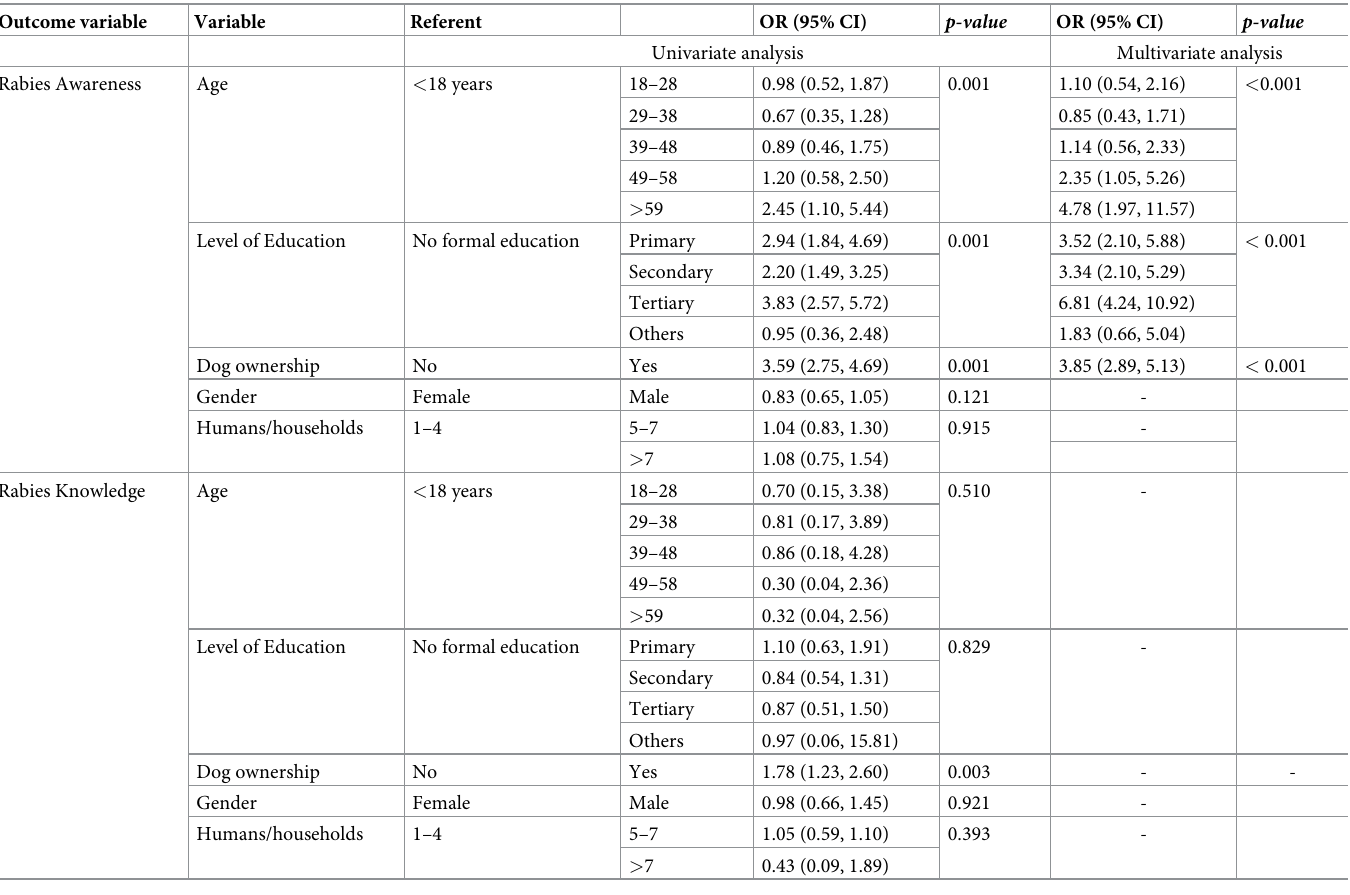
Table 3. Univariate and multivariate logistic regression analysis of demographic variables affecting awareness and knowledge of canine rabies in Kwara